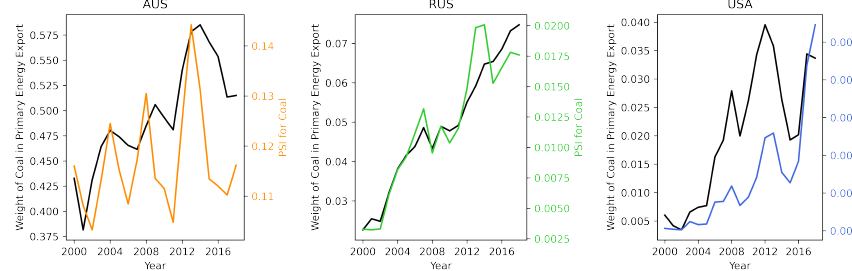
Figure 22. The evolution of PSI for coal